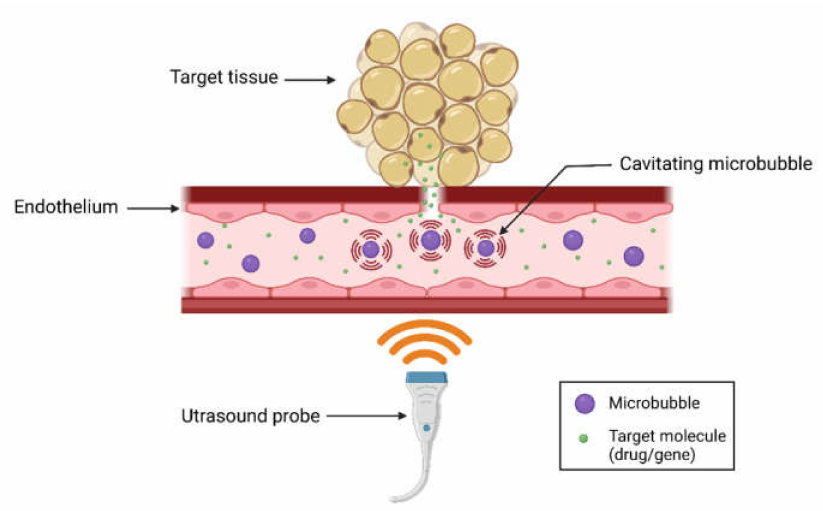
Figure 2. Basic principle of ultrasound-microbubble (USMB)-mediated drug and gene delivery. When microbubbles flowing through the blood are exposed to the ultrasound field, they undergo rapid changes in size and shape (i.e., cavitation), inducing high shear stresses on the surrounding endothelium. This increases vascular permeability and cellular internalization (e.g., endocytosis), leading to targeted delivery of drugs/genes in the area of insonation. The result is enhanced delivery of therapeutic cargo to the local endothelium itself and to the organ being perfused. Created with